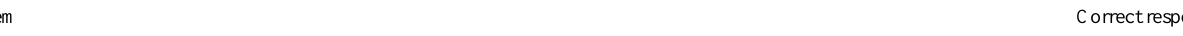
Table 4. Numbers of participants who correctly answered individual items on the scale measuring knowledge about COVID-19 (N=1243), n (%). F: correct answer is false; T: correct answer is true.